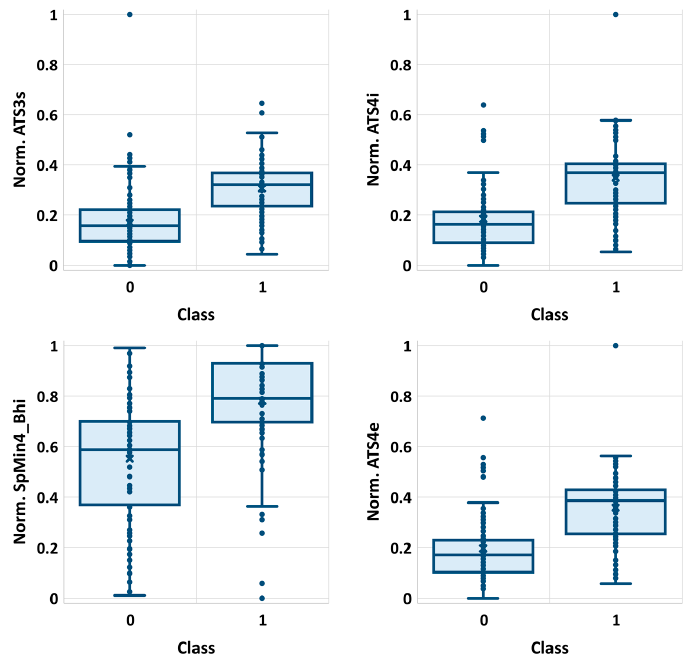
Figure 2. The distributions of four exemplary descriptors (normalized values) characterized by the highest (ATS3s, ATS4i) and the lowest (SpMin4_Bhi, ATS4e) χ 2 values.